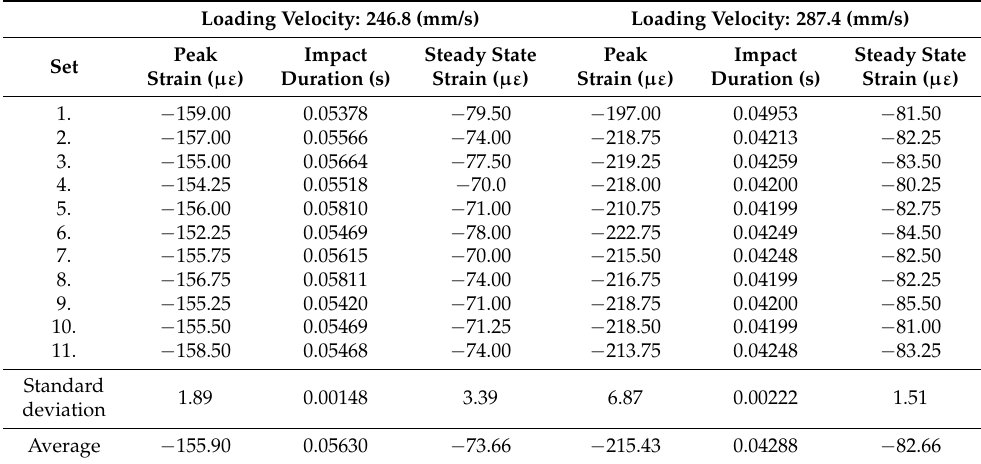
Table 3. Peak strain, impact duration, and steady state strain measured in 11 sets of experiments for two loading velocities.